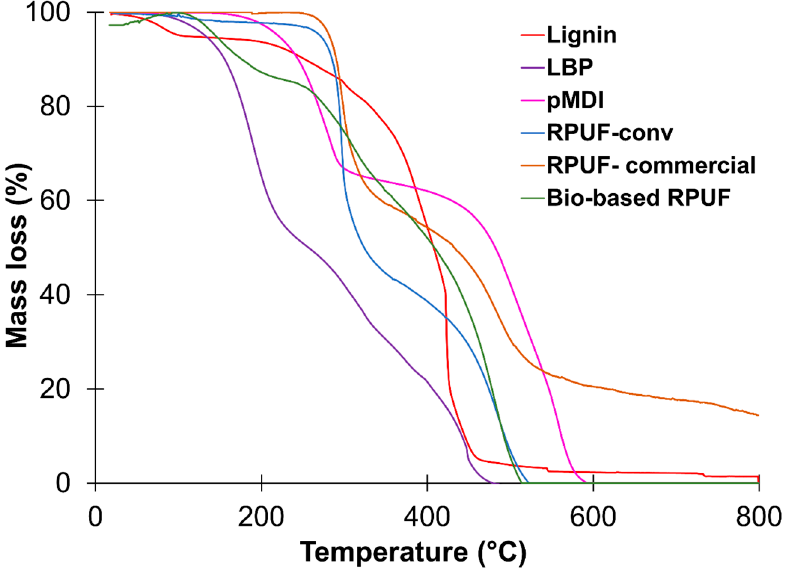
Figure 6. Mass loss of RPUF, lignin, LBP, and pMDI as a function of temperature.